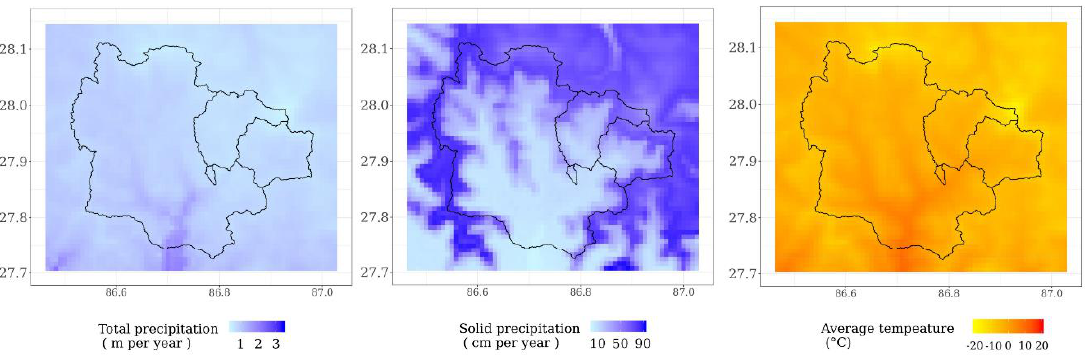
Figure 3. Maps of the average total and solid precipitation and the air temperature for the river basins studied over the period 2013–2016. Values are given for the total area of the basins, including the glaciated areas.